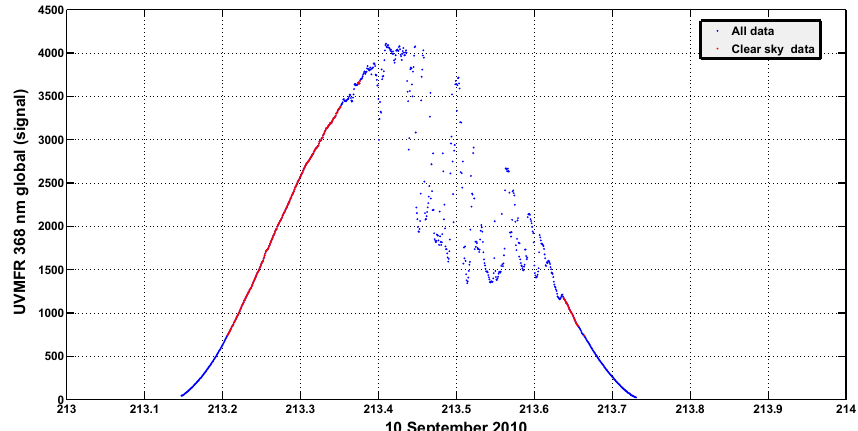
Figure 2. Determination of cloudless 1min measurements (red), from all measurements (blue) for a day with variable cloudiness in the afternoon.